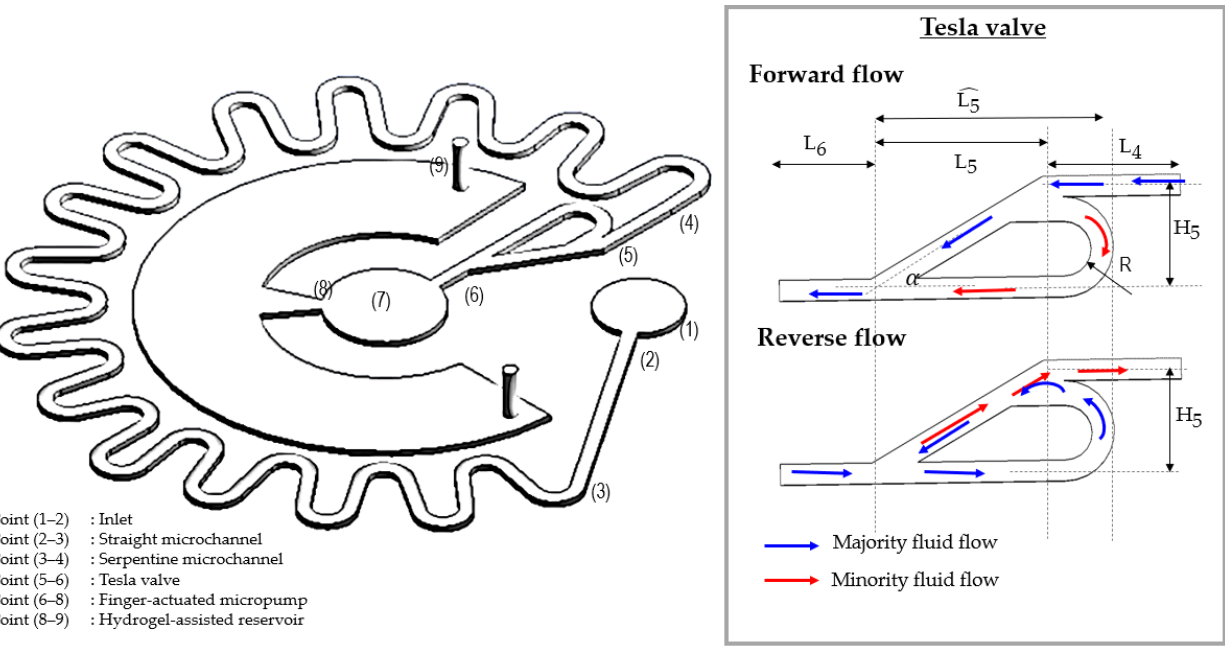
Figure 4. Schematic for micro fl uidic network.